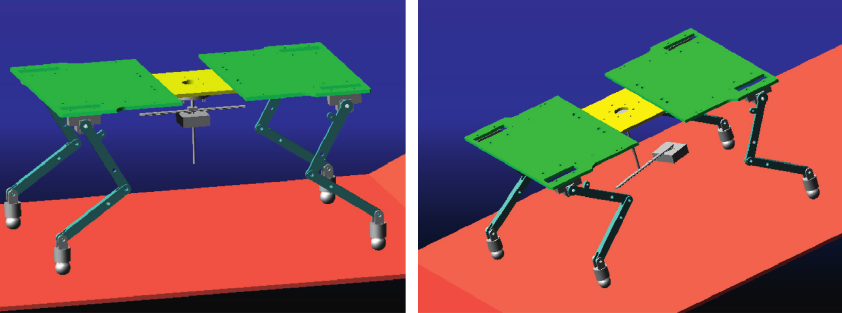
Figure 12: Model of chassis with BAM used in the simulation.